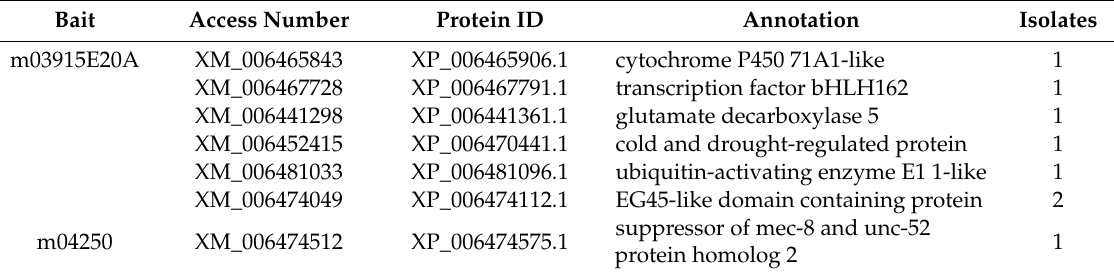
Table 1. The host proteins interacted with mature proteins of CLIBASIA_03915 and CLIBASIA_04250. Bait Access Number Protein ID Annotation Isolates cytochrome P450